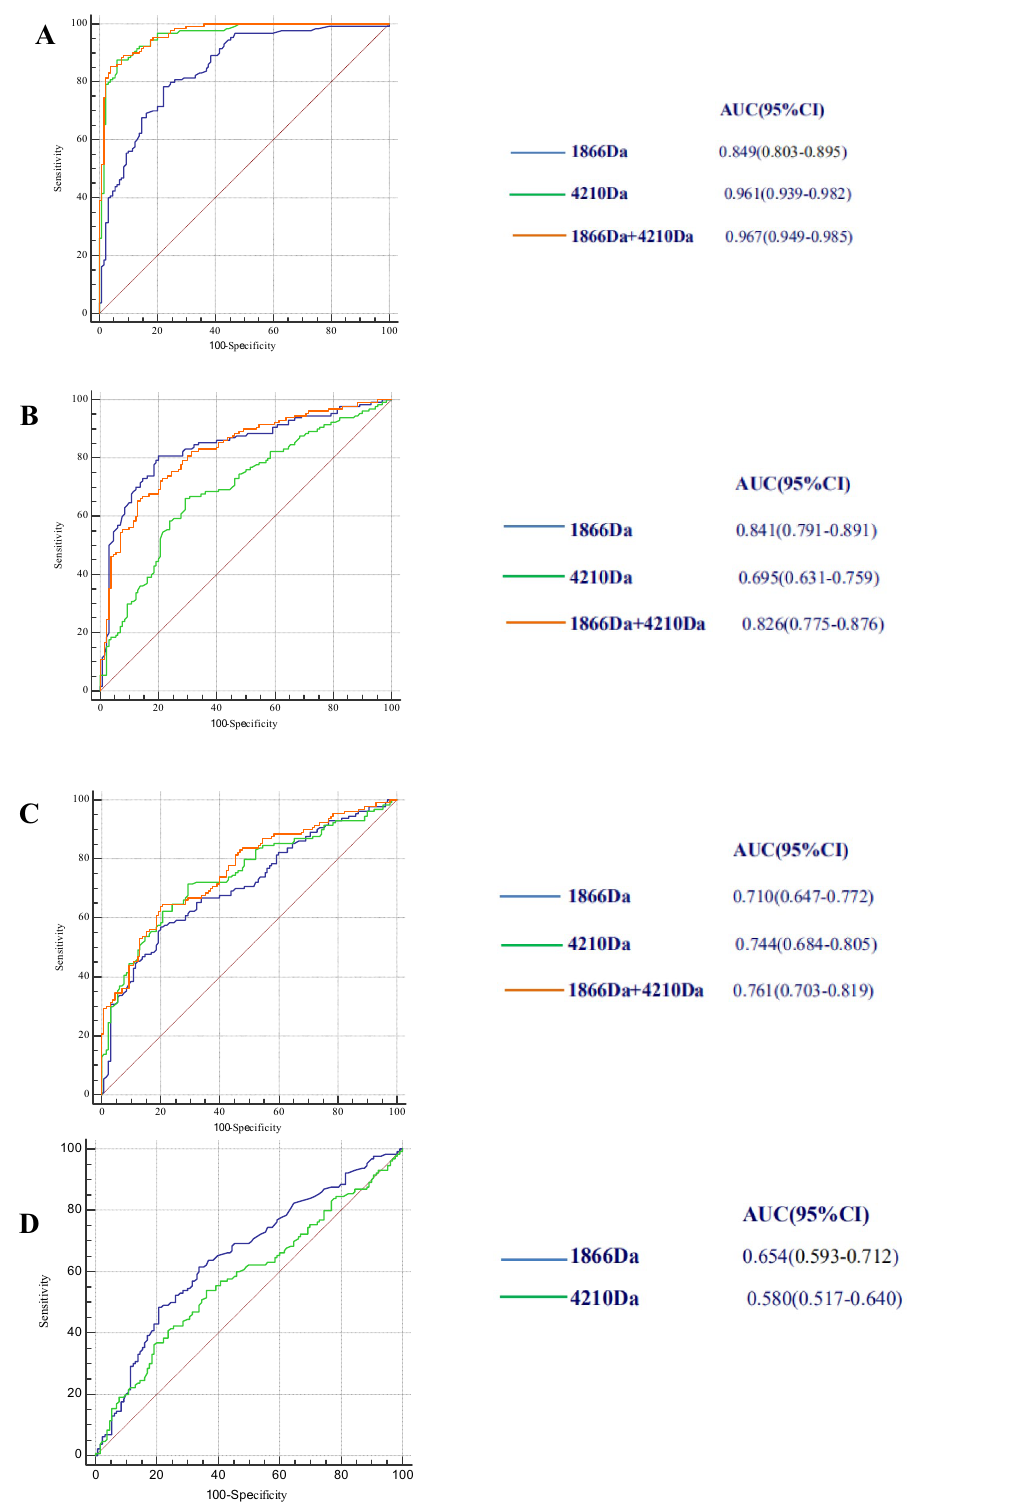
Figure 2. ROC curves of 1866 Da, 4210 Da, and their combination. ( A ) ROC curves of 1866 Da, 4210 Da, and their combination for the differential diagnosis of CHB from normal liver ( P < 0.001 for 4210 Da vs. 1866 Da, P < 0.001 for 1866 Da plus 4210 Da vs. 1866 Da alone, P = 0.189 for 1866 Da plus 4210 Da vs. 4210 Da alone). ( B ) ROC curves of 1866 Da, 4210 Da, and their combination for the differential diagnosis of LC from CHB ( P < 0.001 for 4210 Da vs. 1866 Da, P = 0.231 for 1866 Da plus 4210 Da vs. 1866 Da alone, P < 0.001 for 1866 Da plus 4210 Da vs. 4210 Da alone). ( C ) ROC curves of 1866 Da, 4210 Da, and their combination for the differential diagnosis of HCC from CHB (p = 0.382 for 4210 Da vs. 1866 Da, p = 0.040 for 1866 Da plus 4210 Da vs. 1866 Da alone, p = 0.384 for 1866 Da plus 4210 Da vs. 4210 Da alone). ( D ) ROC curves of 1866 Da, 4210 Da for the differential diagnosis of HCC from LC (p = 0.166 for 4210 Da vs. 1866